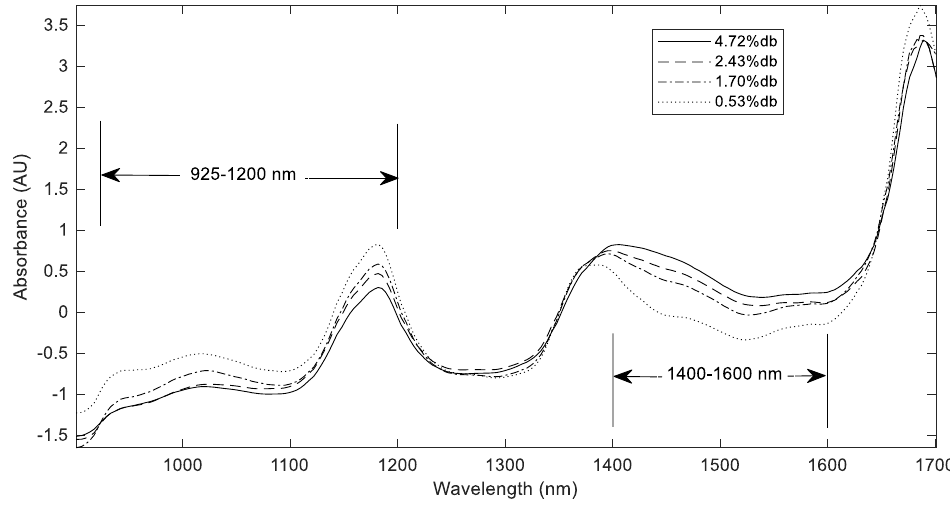
Fig. 4. Mean spectra of the rubber sheets with di®erent moisture contents. Fig. 4, the absorbance value of spectra di®er clearly, while the higest spectrum line corresponds to the high rubber content in the sample. The functional Þ in the groups of the rubber polymer (CH, CH 3 sample strongly vibrated in this region, 6 especially at 925, 1140, 1200, 1351, and 1659 nm as shown in Fig. 5, where peaks were visible in the spectra pre- processed using the ¯rst derivative. The CH func- tional groups vibrated in the second and third overtone regions, around 1200 and 925 nm, 5 respec- tively, while around 1140 nm and 1351 nm, the CH 3 functional groups vibrated in the second overtone region, and at around 1659 nm in the ¯rst overtone region. 29 In region 1400 – 1600 nm in Fig. 4, the lowest